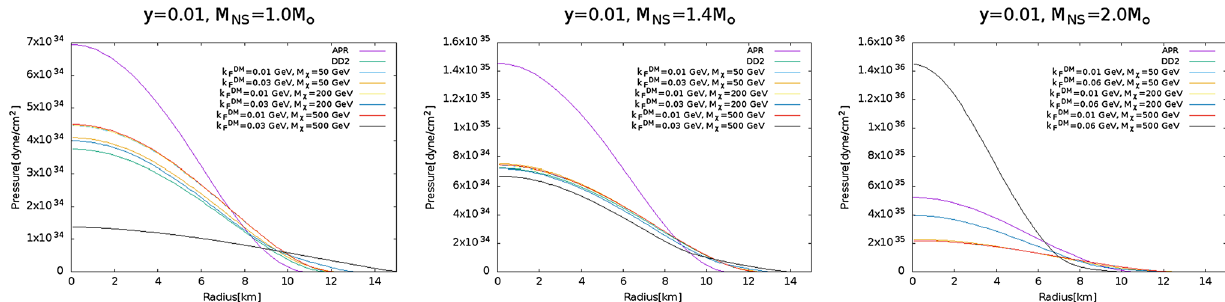
Fig. 3 Pressure vs radius plots for M NS = 1 . 0 M (cid:8) (left panel), M NS = 1 . 4 M (cid:8) (middle panel), M NS = 2 . 0 M (cid:8) (right panel) with varying DM mass and Fermi momentum in each